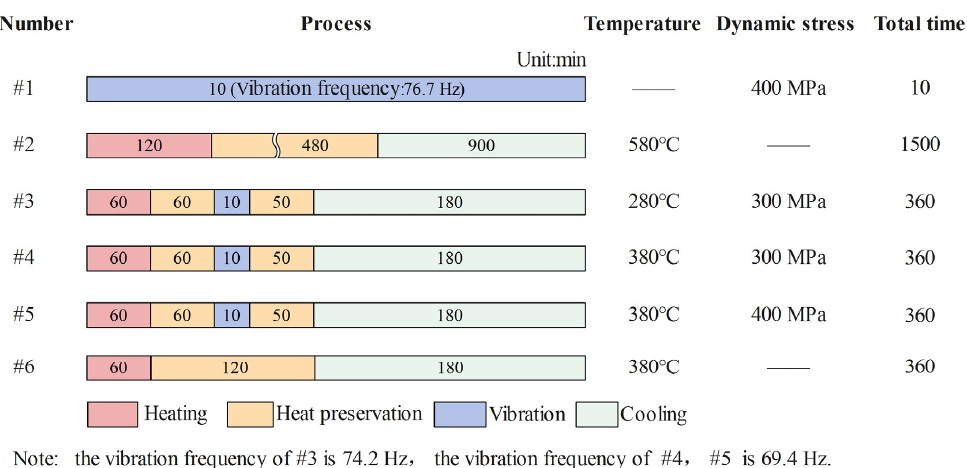
Figure 4. Arrangement of residual stress relief experiments.